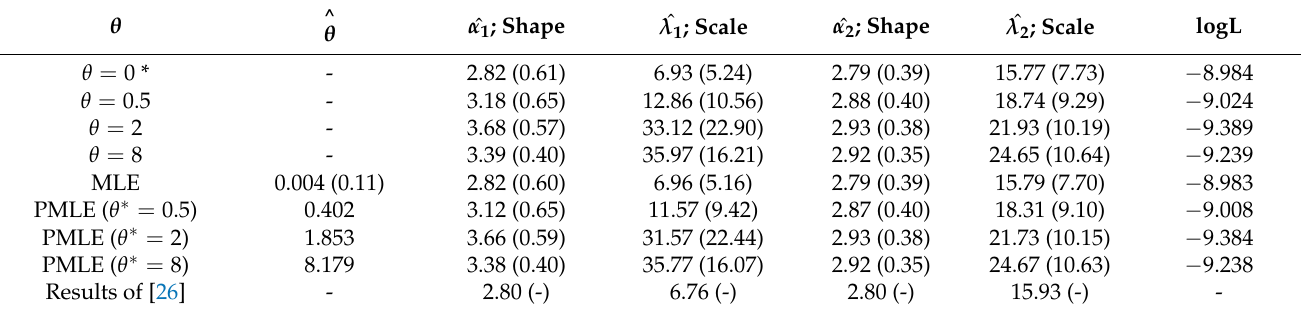
Table 6. The estimates (SEs in parenthesis) for the Clayton copula model with the Weibull failure times based on the dataset from Kundu et al. [26]. The Clayton copula with fixed θ or estimated θ are